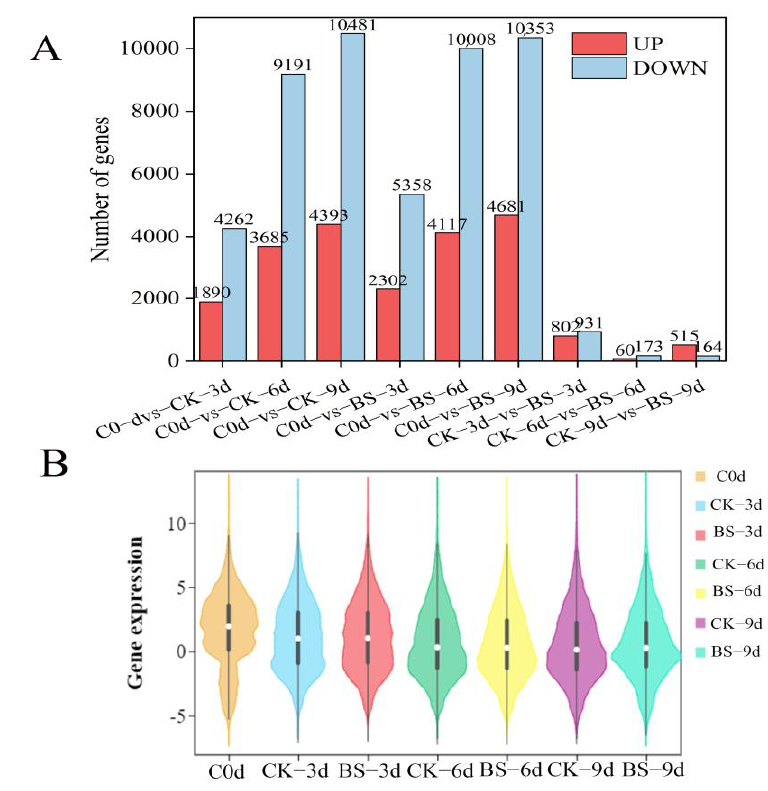
Figure 2. Statistics of differentially expressed genes in all mango fruit groups. ( A ) Bar chart of the number of all DEGs. ( B ) Violins in all groups (the white dot in the middle of the box is the median, the upper and lower edge of the box type is 75%, and the upper and lower limit is 90%).